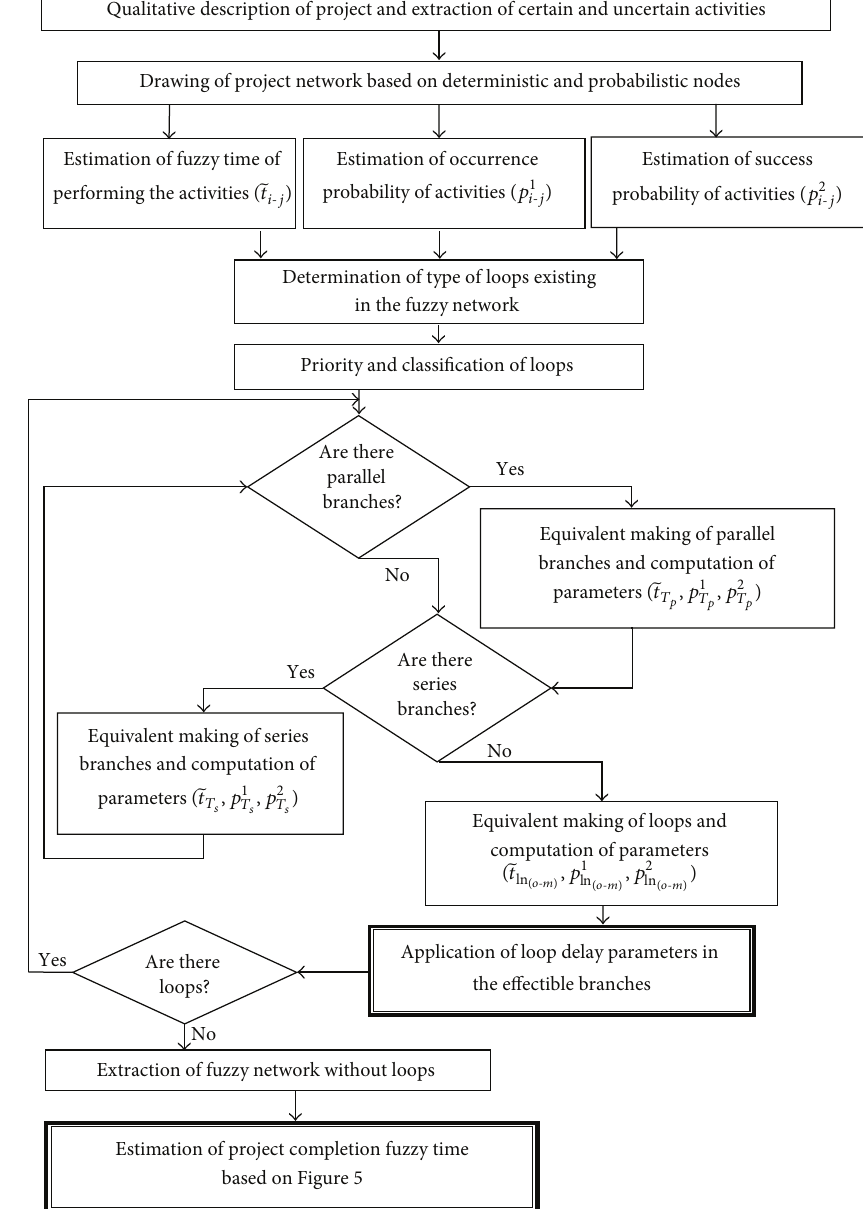
Figure 1: A graphical presentation of the proposed